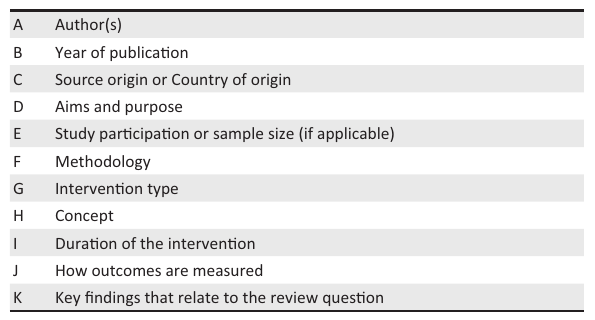
FIGURE 1-A1: Extraction form for narrative